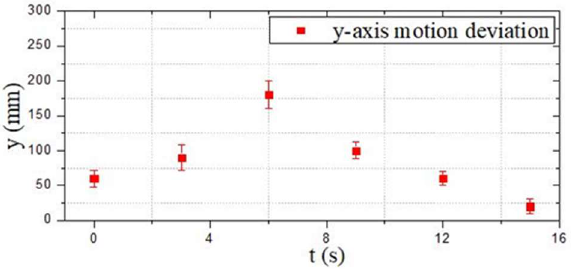
Figure 16. Motion deviation in the y -axis direction (the first experiment).